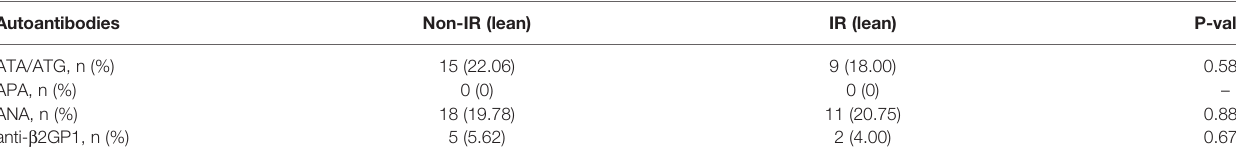
TABLE 2 | Auto-immune parameters between insulin resistant (IR) and non-insulin resistant (Non- IR) infertile women. Autoantibodies